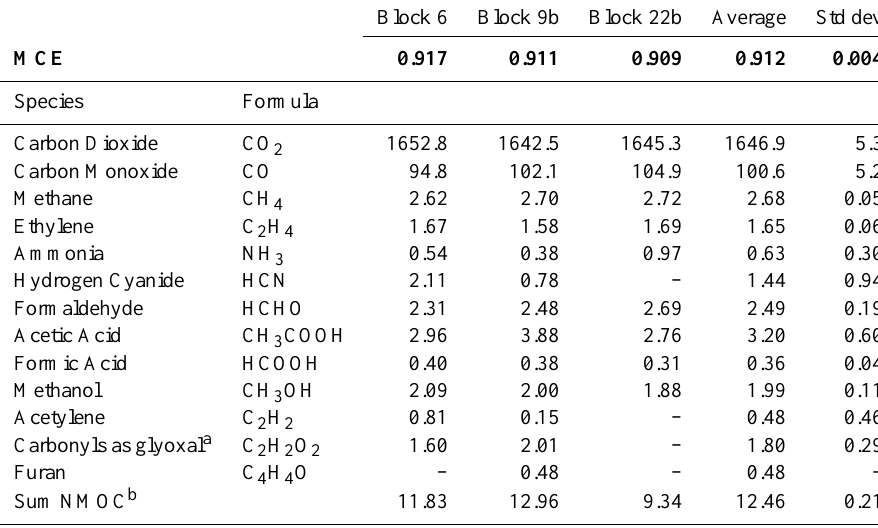
Table 1. MCE (bolded) and EFs (gkg − 1 ) for three pine understory burns measured by